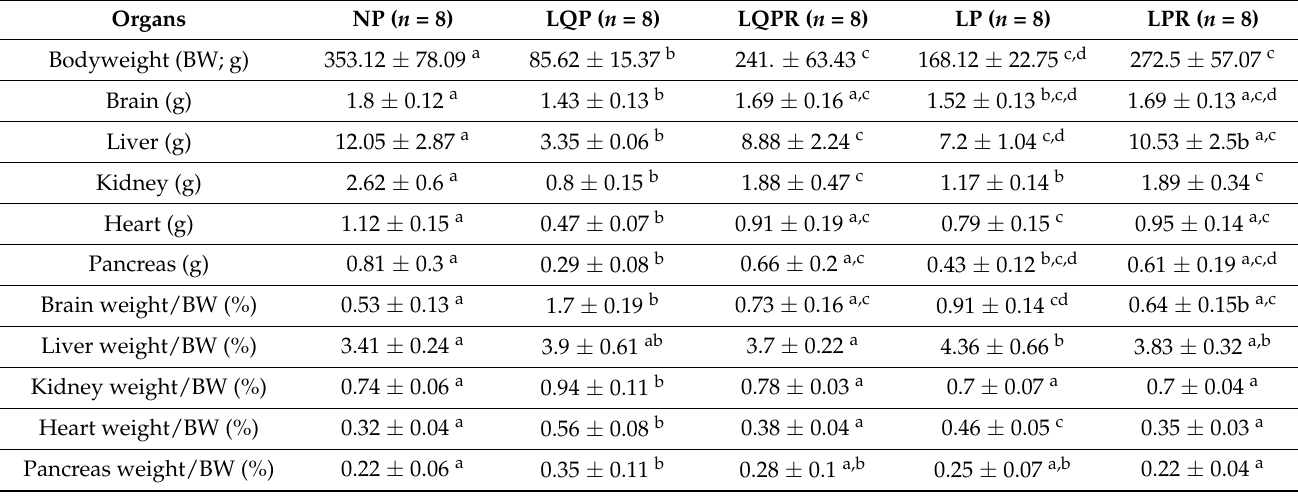
Table 5. Effect of maternal quality and quantity protein restriction followed by rehabilitation on the organ weights in the